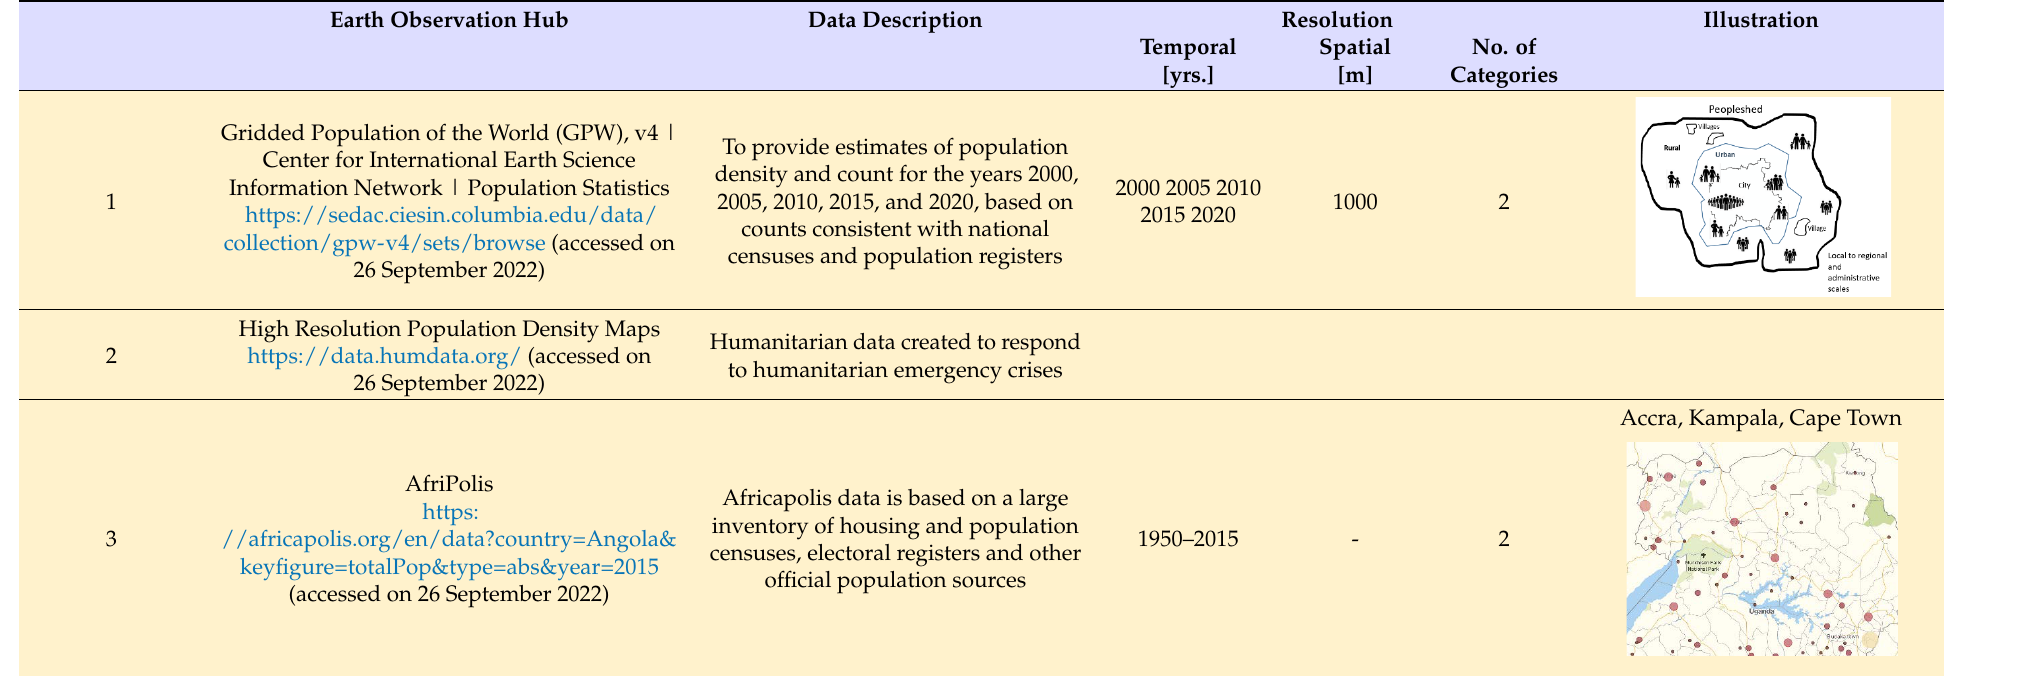
Table 4. Publicly available dataset for spatially referenced demographic